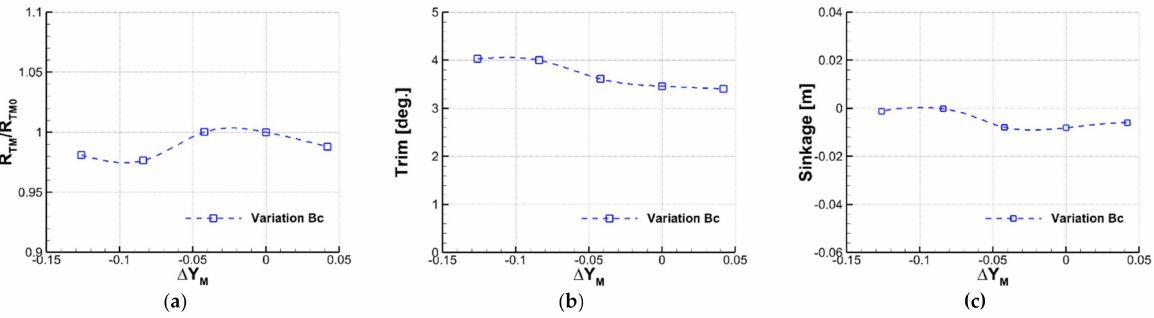
Figure 7. Variation of total resistance, trim, and sinkage depending on design parameter ∆ Y M . ( a ) Ratio of total resistance; ( b ) Trim; ( c )